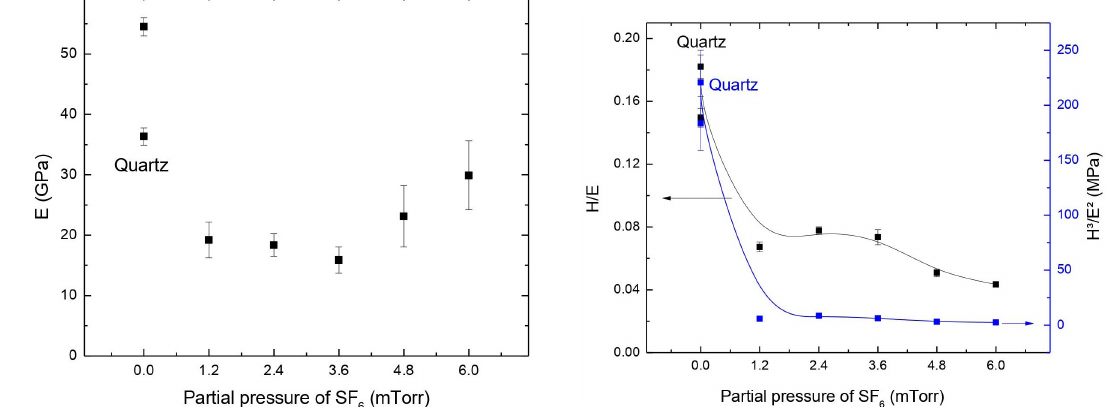
Figure 14. Young’s modulus as a function of R